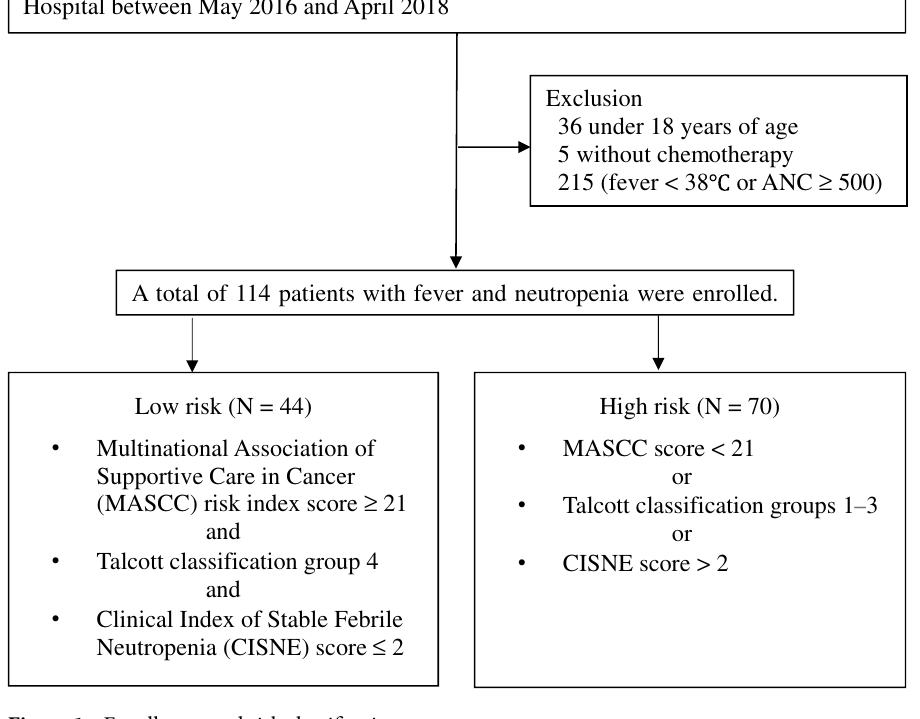
Figure 1. Enrollment and risk